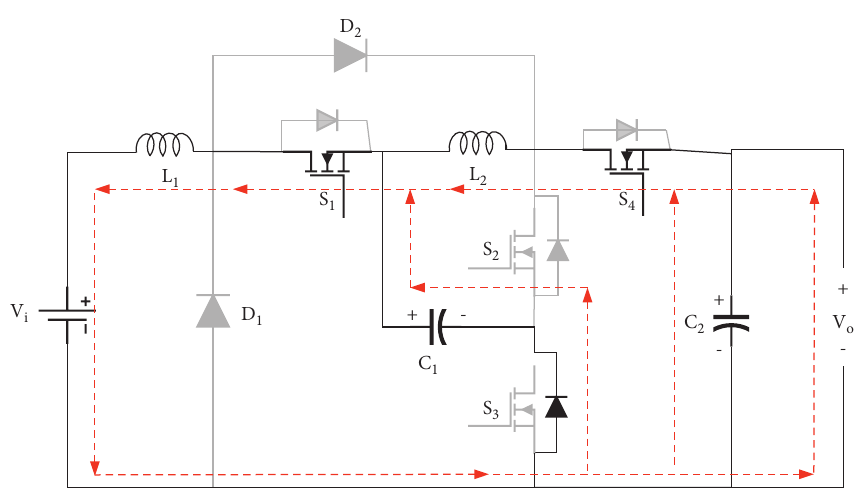
Figure 6: Convers’ buck mode operation in mode